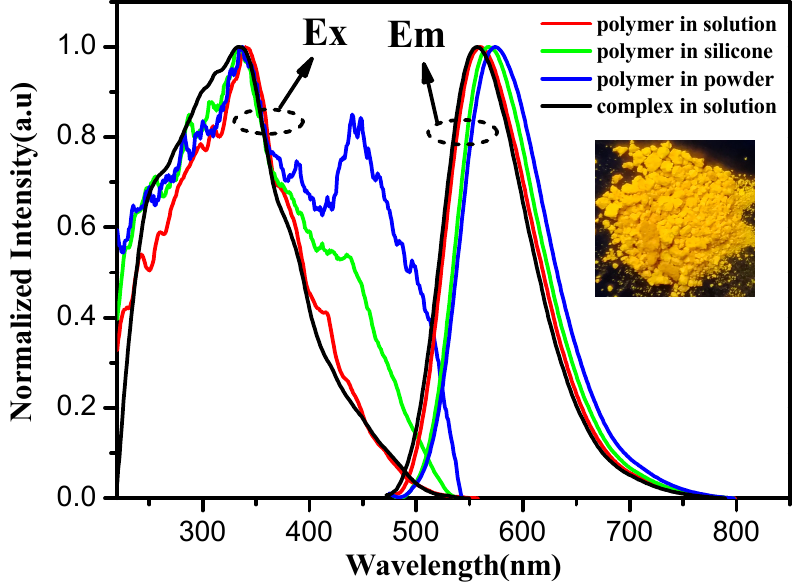
Figure 1. Normalized excitation (Ex) and emission (Em) spectra of the cationic iridium(III) complex (i.e., compound 4 ) in CH 2 Cl 2 solution (1 × 10 − 5 mol · L − 1 ), as well as those of the polymer in CH 2 Cl 2 solution (0.001 wt %), blended in silicone (2.0 wt %, coated on quartz plate), and in powder; the corresponding emission wavelengths were 557, 560, 568, and 574 nm, respectively, and the corresponding excition wavelengths all were 460 nm. Inset: an image of the polymer powder excited by 460 nm blue light.